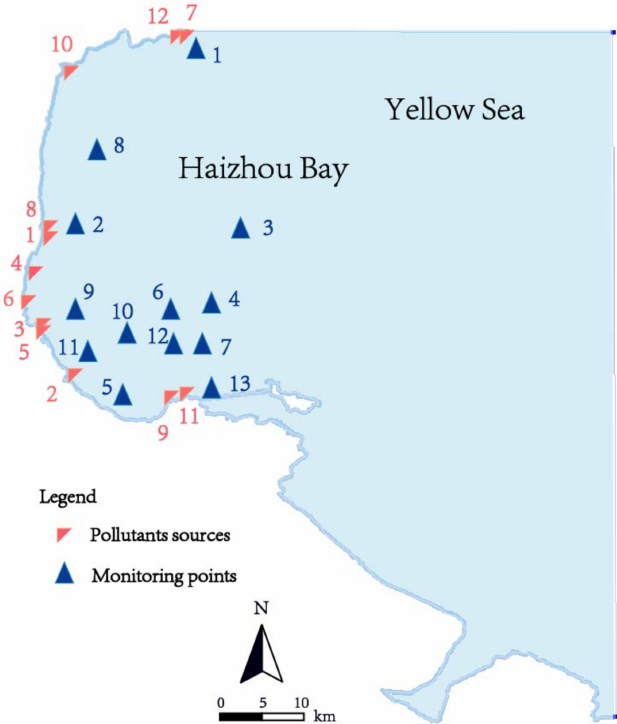
Figure 5. Pollution sources and water quality monitoring sites (sources: 1–5, river estuaries; 6, wastewater treatment plant outfalls; 7, petrochemical company; 8, chemical company; 9, alkali factory; 10, biochemical company; 11, wastewater treatment plant outfalls; 12, wastewater treatment plant outfalls).